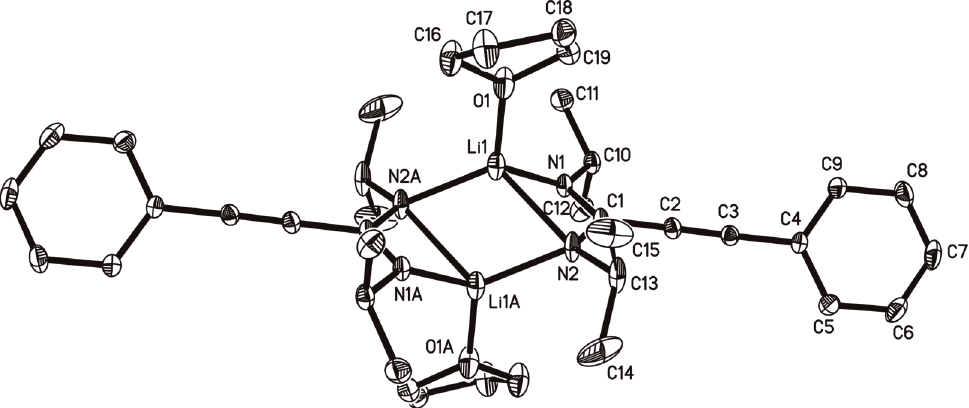
Figure 1. Molecular structure of 1 in the crystal, showing the atom-labeling